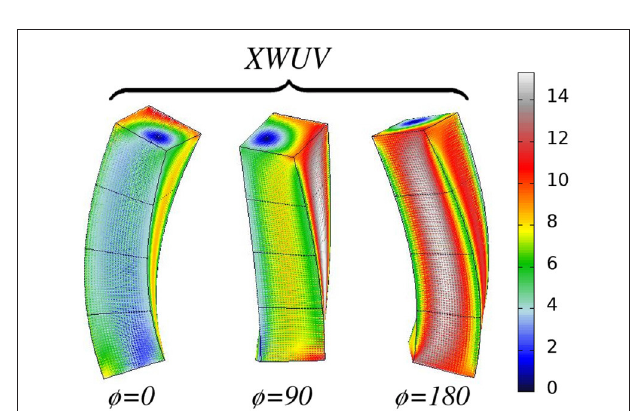
FIGURE A6 | Shear force variation across the width of the mid-section of a 25 × 25 × 201 square beam, with parabola expression included for comparison shown in red.